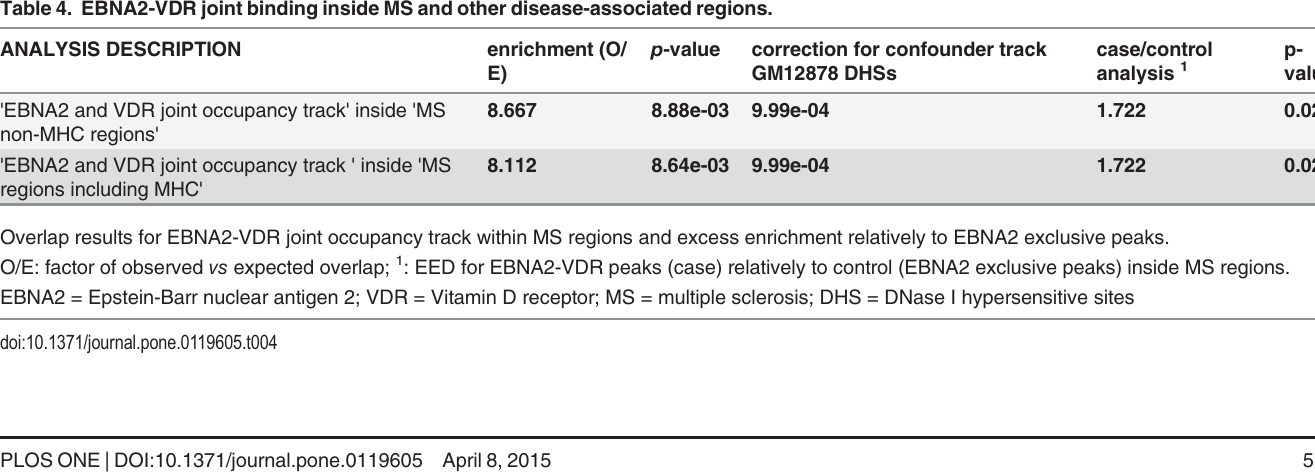
regions genetically associated with diseases sharing EBV as major environmental risk factor. In the attempt to identify a more MS-specific signature in EBNA2 distribution, we then in-